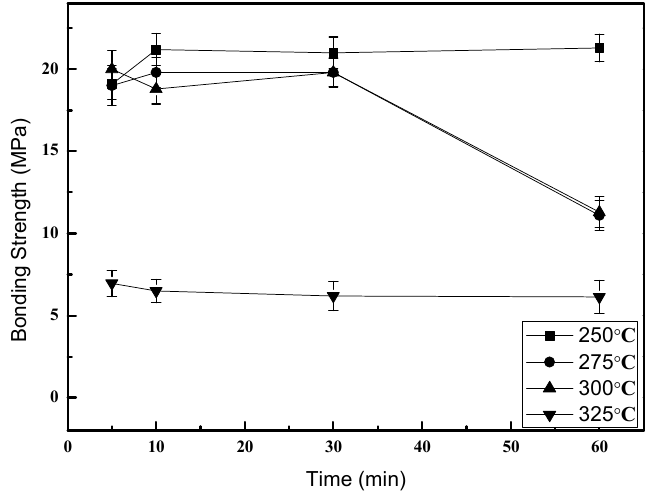
Figure 9. Shear strengths of Bi 2 Te 2.55 Se 0.45 /Cu joints bonded with the diffusion soldering process using a Sn interlayer.